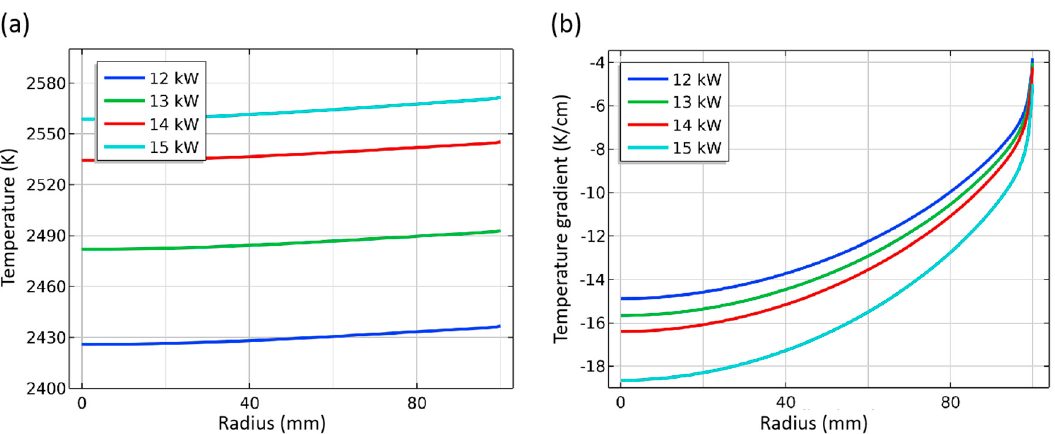
Figure 9. Temperature distribution in the chamber.